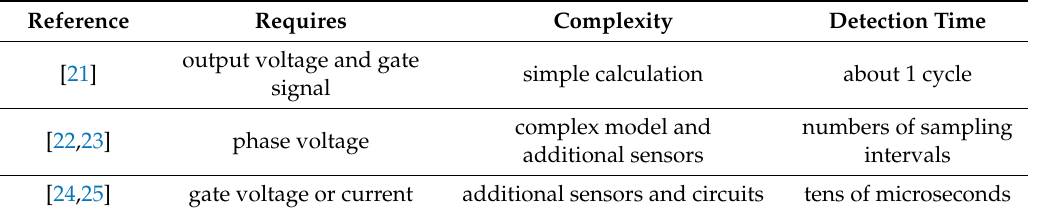
Table 1. Fault detection